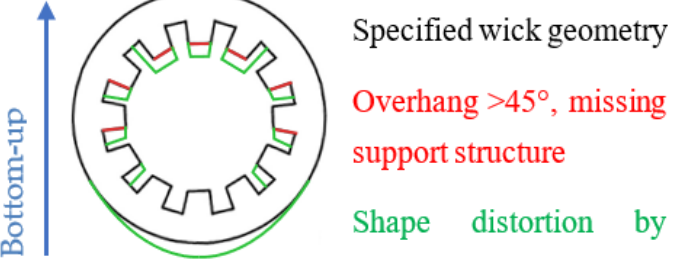
Figure 7. Problems that occur when horizontally printing grooved wick